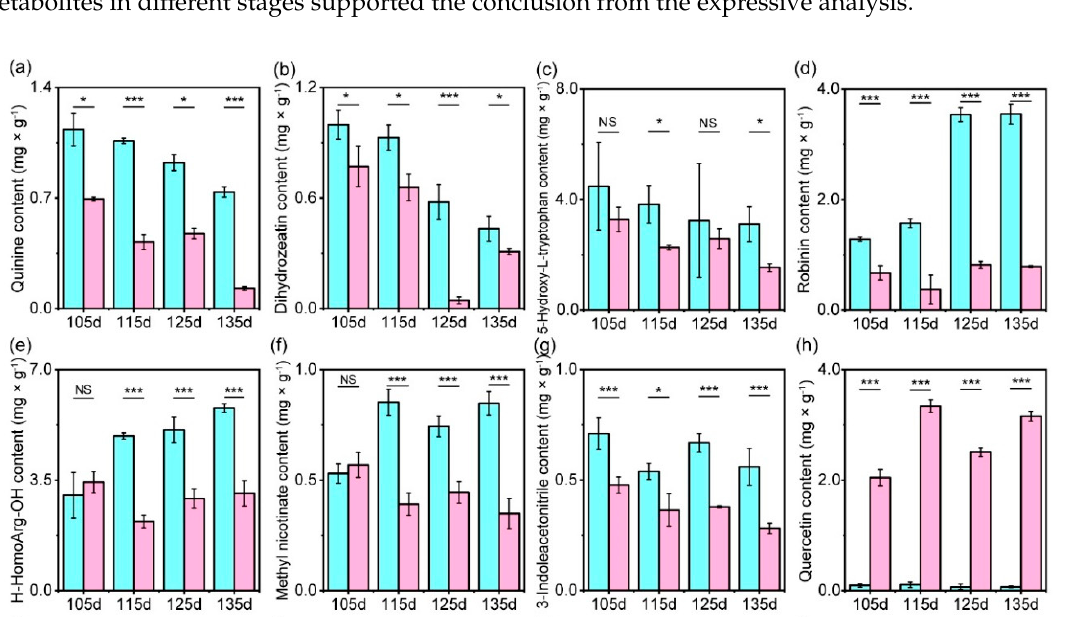
Figure 4. Concentrations of the 16 selected DEMs in AS and GS at different stages. Metabolites including quinine ( a ), dihydrozeatin ( b ), 5-hydroxy-L-tryptophan ( c ), robinin ( d ), H-homoarg-OH ( e ), methyl nicotinate ( f ), 3-indoleacetonitrile ( g ), quercetin ( h ), kaempferol ( i ), apigenin ( j ), octadecadien- 6-ynoic acid ( k ), protocatechuic acid ( l ), myricetin ( m ), (R)-lipoic acid ( n ), dodecanedioic acid ( o ), and L-asparagine ( p ) were selected randomly. Darker bars indicated the concentrations of the corresponding metabolites in GS group, while the lighter bars indicated that of in AS group. Asterisks above the bars represented the significant level of the difference. Significance at p < 0.01 level was marked with “***”; at p < 0.05 level it was marked with “*”; while at p > 0.05 level it was marked with “ NS ” which meant no significant difference between those samples. 3.5. KEGG Enrichment of Different Expressive Metabolites To further understand the biological function of those DEMs, they were mapped into the KEGG database for the enrichment analysis. The enrichment results and pathways evaluation were showed in Figure 5 and Table S3. DEMs in flavonoid biosynthesis pathway and flavone and flavonol biosynthesis pathway were significantly enriched at p < 0.05 level in all four stages, implying that metabolites in these two pathways existed a significant difference between certain groups. Actually,